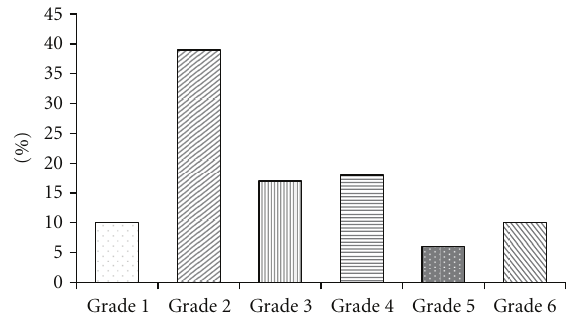
Figure 3: Distribution of rotator tear grading. The bar graph illus- trates the distribution of rotator cu ff tears. The study group included all rotator cu ff tear grades, with the largest proportion of grade 2 tears. There were no normal rotator cu ff s included in the study.